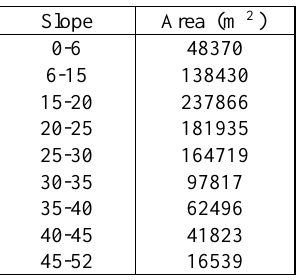
Table 1. The total plantation areas in certain slope ranges.